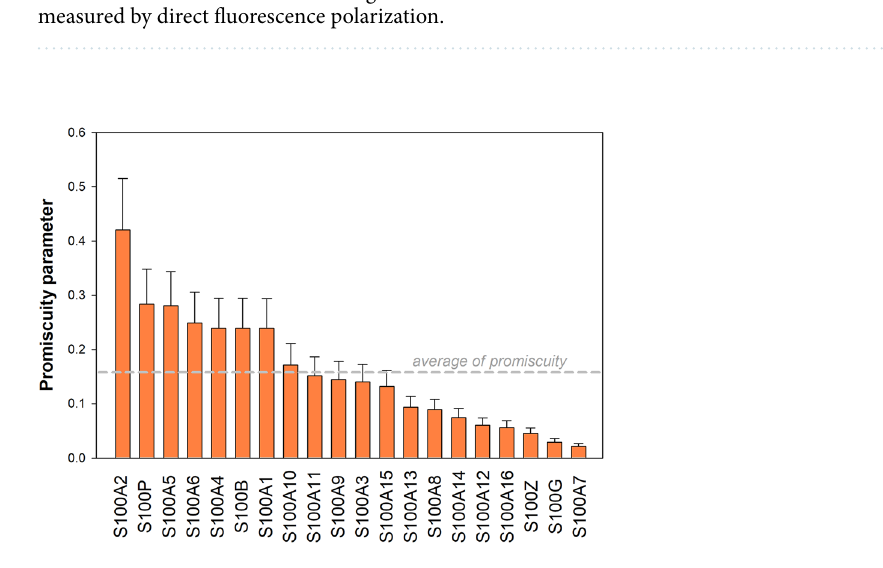
Figure 4. Promiscuity of the S100ome towards the H14 foldamer library. Promiscuity values of the S100ome are defined towards the full H14 foldamer library (all the 256 possible combinations of 16 amino acids in two residues per foldamer building blocks) by averaging all the measured bound fraction values. Mean ± SEM are plotted on the y axis as a bar chart. The promiscuity average was arbitrarily chosen as threshold value for